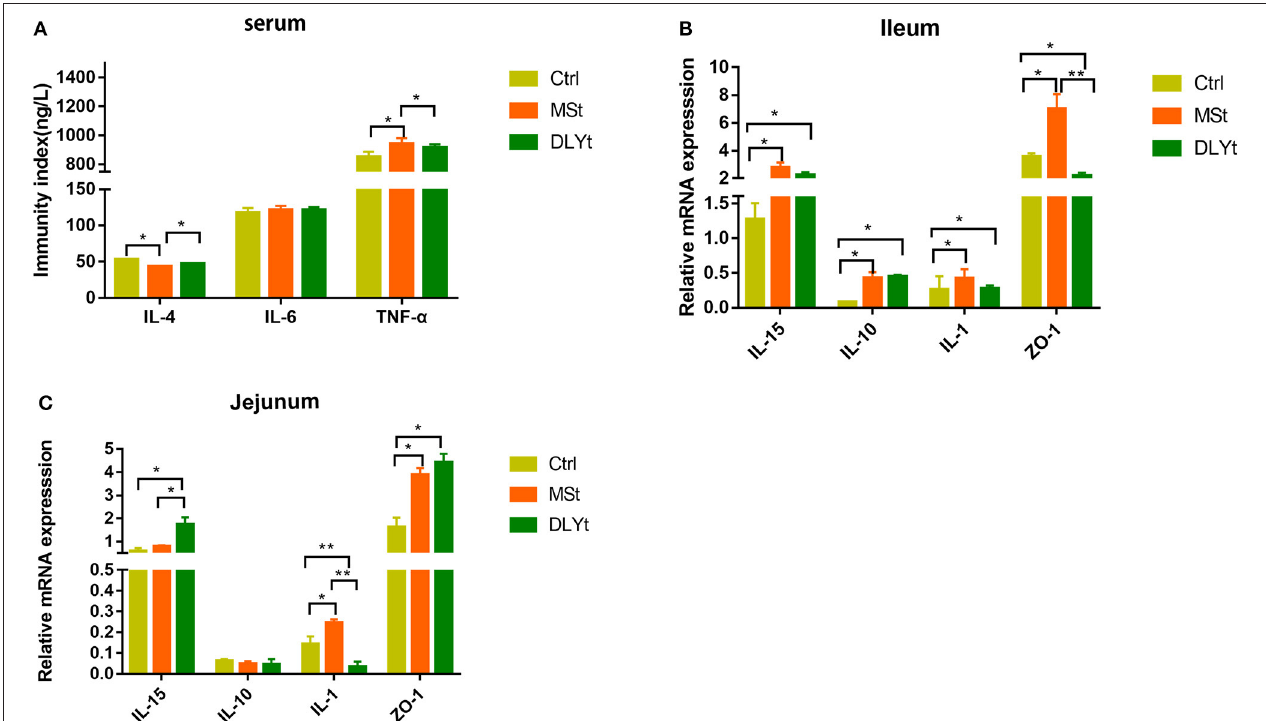
FIGURE 3 | Effect of FMT on immune factors during cold exposure. (A) Interelukin-4 (IL-4), interleukin-6 (IL-6), and tumor necrosis factor- α (TNF- α ) levels ( n = 7/group) in serum. * P < 0.05. (B,C) Results of relative gene mRNA of jejunum (B) and ileum (C) ( n = 7/group). (* P < 0.05, ** P < 0.01, and *** P < 0.001, Duncan’s multiple range test). *** means extremely